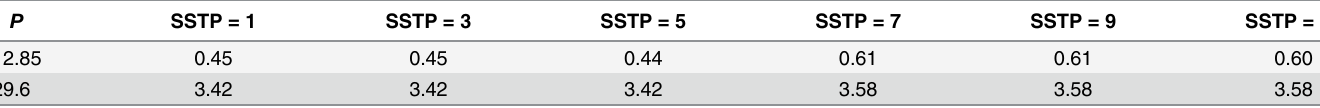
Table 5. Values of t E of the six